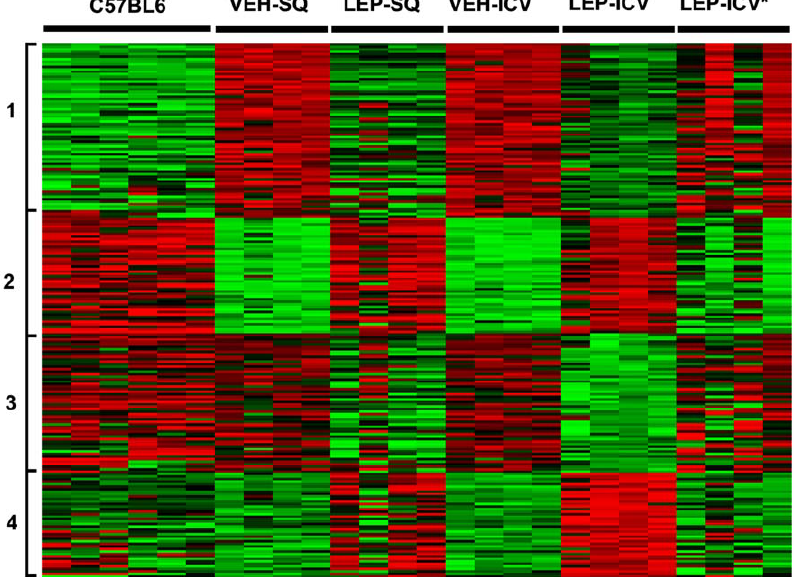
Figure 3. Heatmap of 214 differentially expressed genes showing gene expression levels across different samples. Each row represents one gene and each column represents one sample. Red indicates higher expression and green indicates lower expression. The global gene expression profiles were compared after the central and peripheral leptin treatments in ob/ob mice, while C57BL6 mice were used for the baseline gene expression. Cluster analysis on the gene expression data was performed to group the genes with similar expression patterns across experimental conditions. VEH-SQ: vehicle subcutaneous treatment, LEP-SQ: leptin subcutaneous treatment, VEH-ICV: vehicle intracerebroventricular treatment, LEP-ICV: leptin intracerebroventricular treatment, LEP-ICV * : represents four animals in which the cannula may not have been in place or treatment failed. While analyzing the phenotype data, we found that there was no weight loss in these four animals. Sectioning of the brain could not confirm placement of the cannula in these animals. The expression of these animals is very similar to the vehicle treated animals.